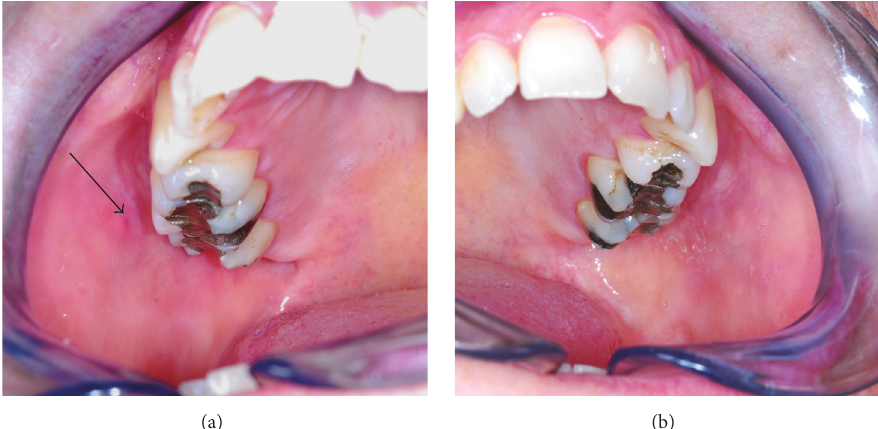
Figure 1: (a) Intraoral view of the right buccal mucosa shows the papilla of Stensen’s duct. (b) Intraoral view of the left buccal mucosa. The papilla of Stensen’s duct is absent.